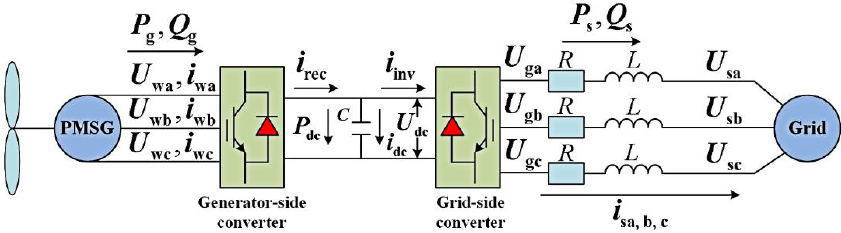
Figure 2. Topological structure of a permanent magnet synchronous generator (PMSG) wind power system.